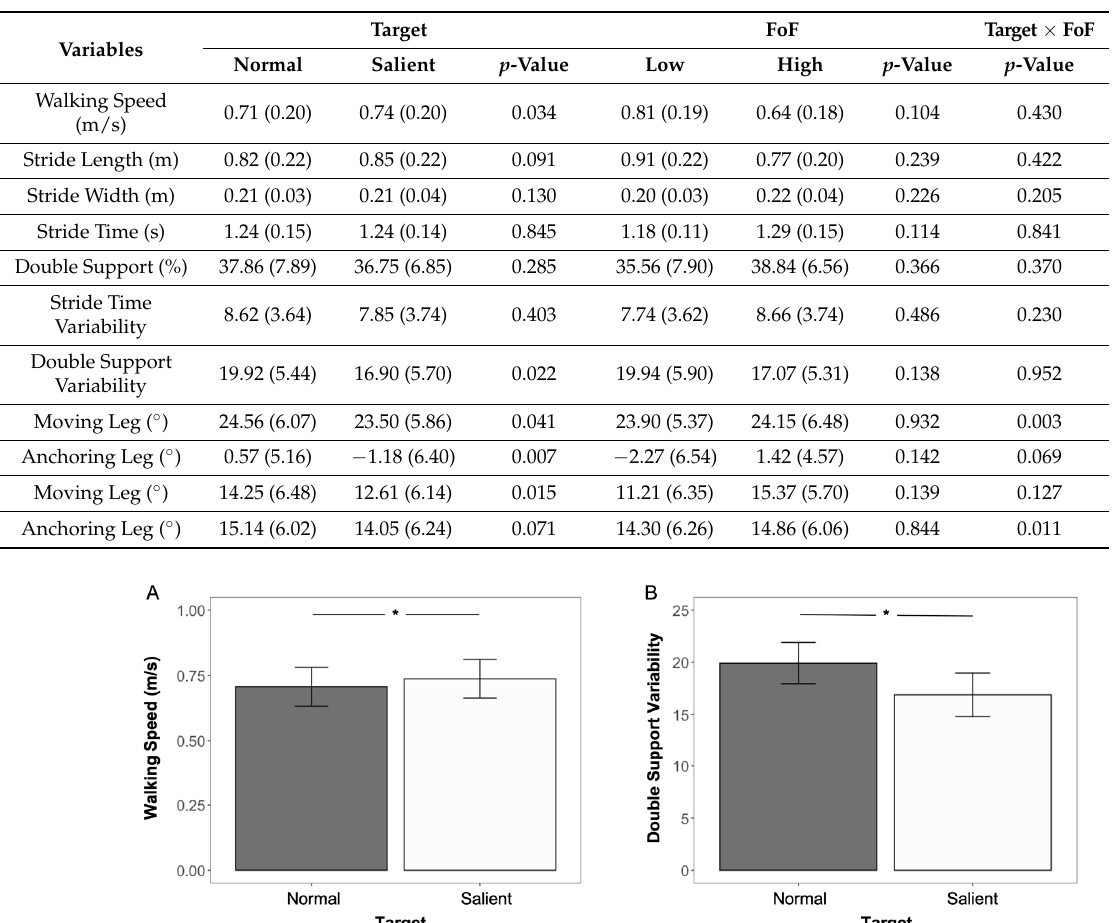
Table 2. Mean, standard deviation (SD) values, and ANOVA results of gait variables.